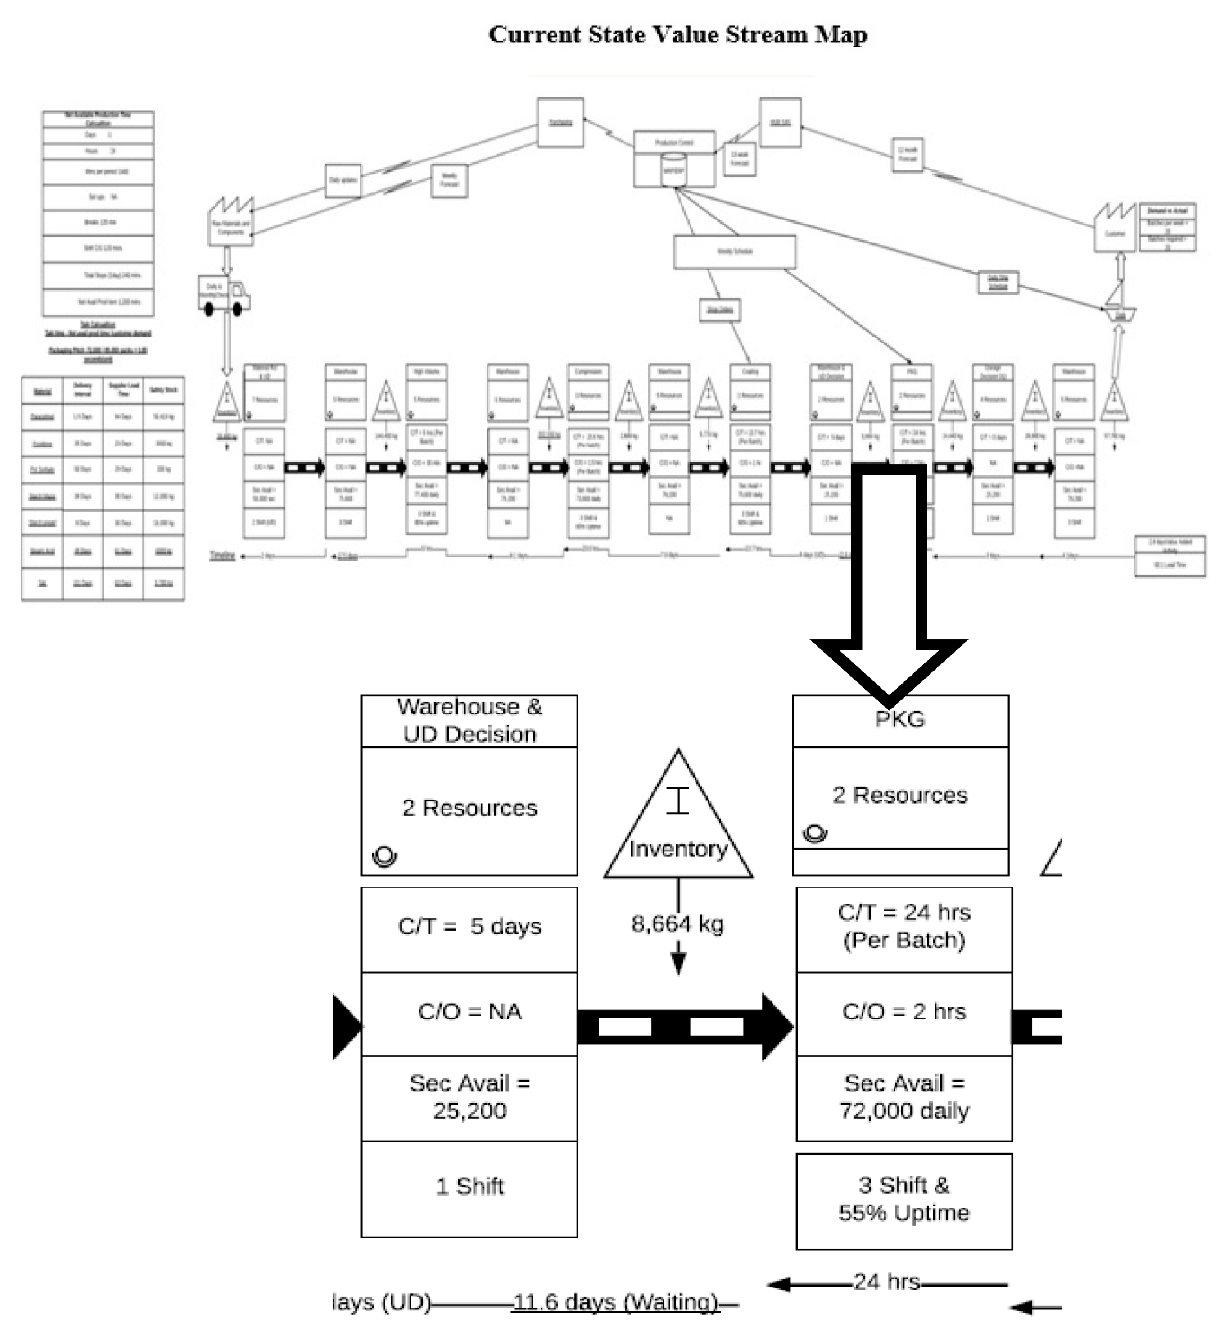
Figure 2. A Current Value Steam Map with the packaging area section highlighted showed that there was a backlog of inventory or product waiting to go into packaging of 11.6 days of work in progress (WIP).